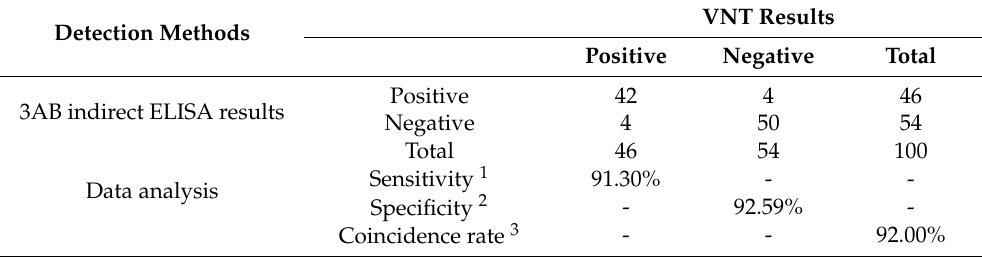
Table 2. Comparison of the indirect 3AB-ELISA with VNT.